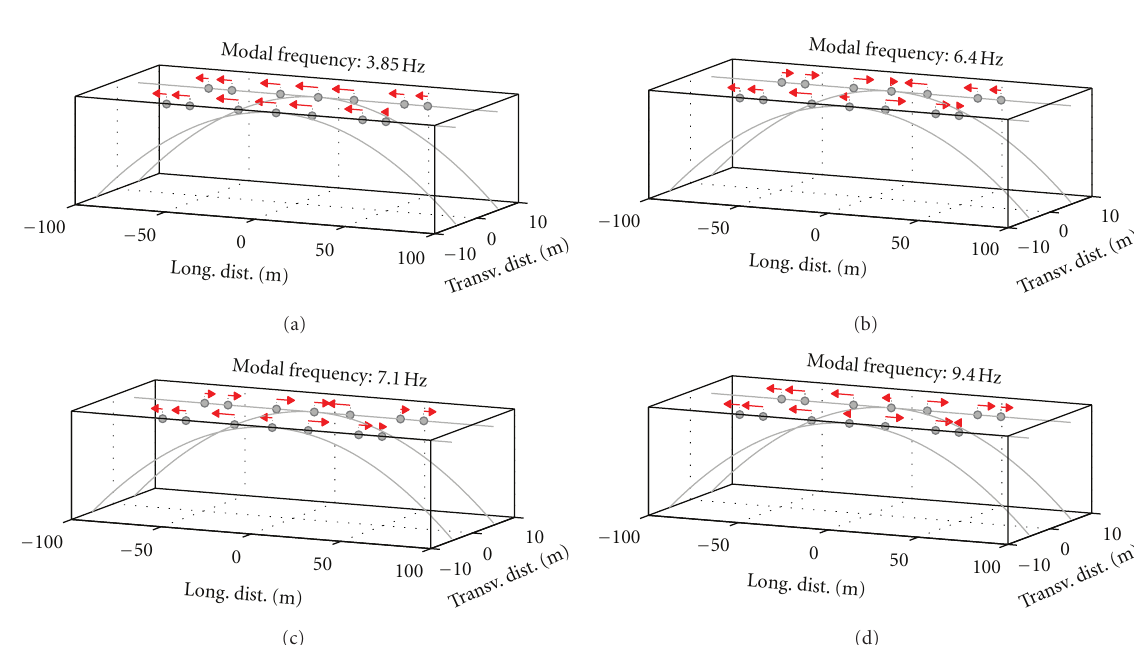
Figure 10: Same as Figures 8 and 9, but for the longitudinal component, that is, compression/dilatation of the bridge deck. Note that the relative direction of motion and amplitude of displacement in the longitudinal direction are represented through the arrow direction and length,